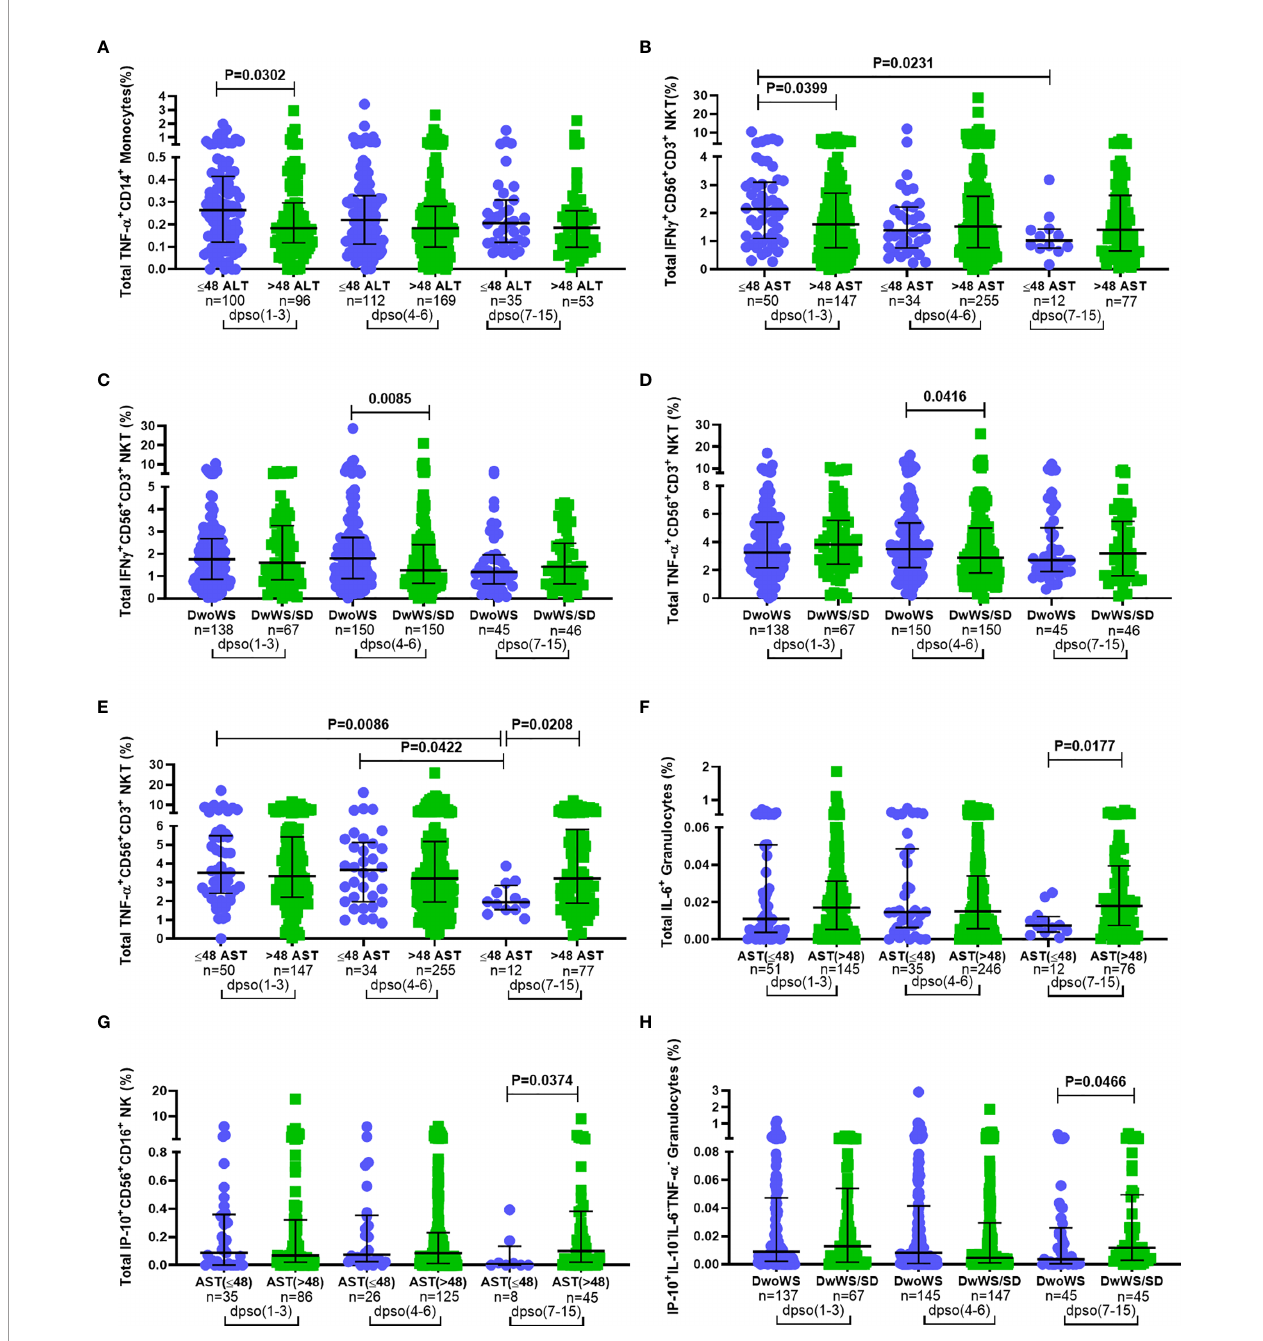
FIGURE 7 | Correlation between disease severity and kinetics of innate immune cell activation. Frequency of total (A) TNF- a + CD14 + monocytes and (B) IFN- g + CD56 + CD3 + NKT cells compared between normal (circle) and high (square) levels of ALT and AST ( A and B respectively; IU/L). Frequency of total (C) IFN- g + CD56 + CD3 + NKT cells and (D) TNF- a + CD56 + CD3 + NKT compared between DwoWS (circle) and DwWS/SD (square). Frequency of total (E) TNF- a + CD56 + CD3 + NKT cells (F) IL-6 + granulocytes in total cohort and (G) IP-10 + CD56 + CD16 + NK cells in primary dengue cohort compared between normal (circle) and high (square) AST levels. Frequency of (H) monofunctional IP-10 + granulocytes compared between DwoWS (circle) and DwWS/SD (square) severity groups. All comparisons